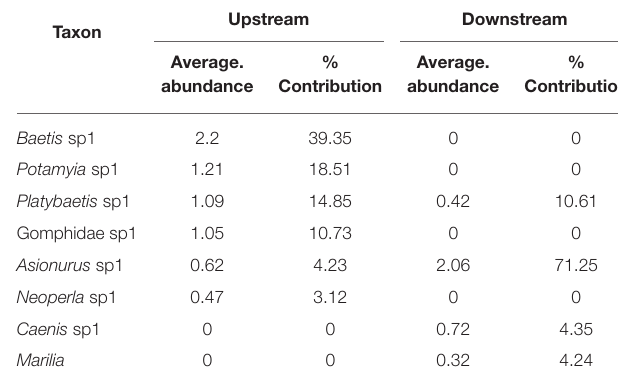
TABLE 4 | The percentage of contribution of all taxa with their average abundance between sampling locations (upstream and downstream) of the Yewar